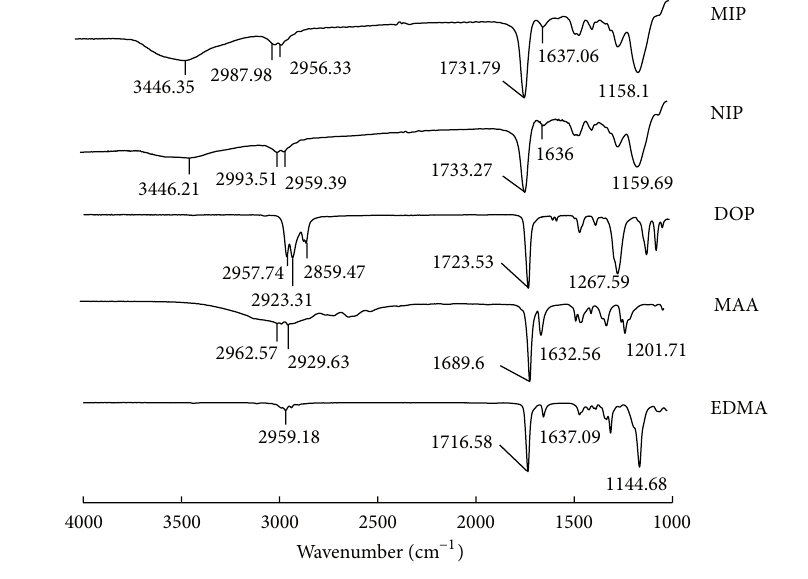
Figure 3: FT-IR spectra of MAA, EDMA, DOP, MIP, and